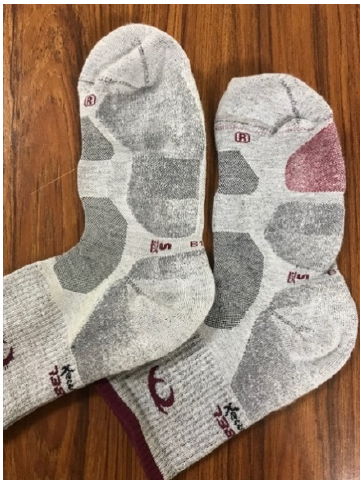
Figure 1. Detail of the two socks, control (left) and experimental (right).